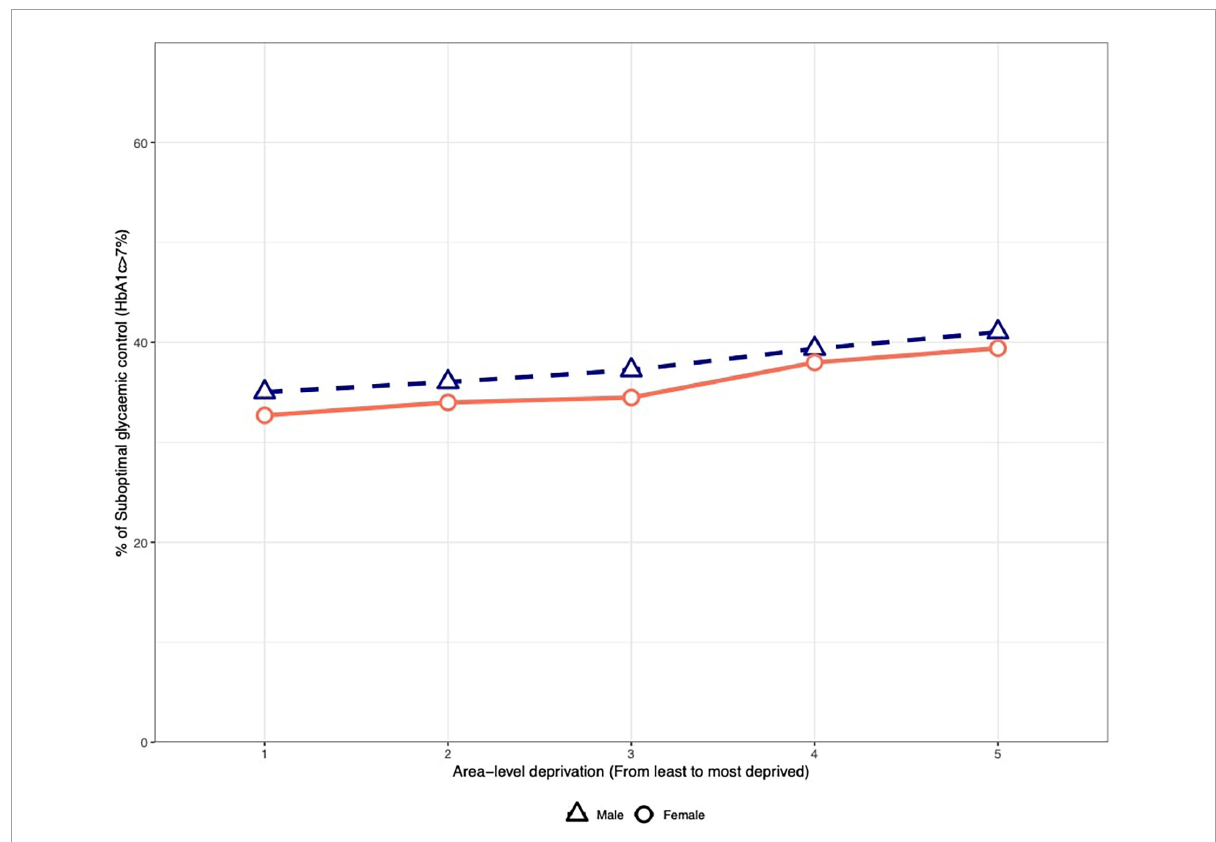
FIGURE1 Suboptimal glycemic control based on the socioeconomic status index and sex.